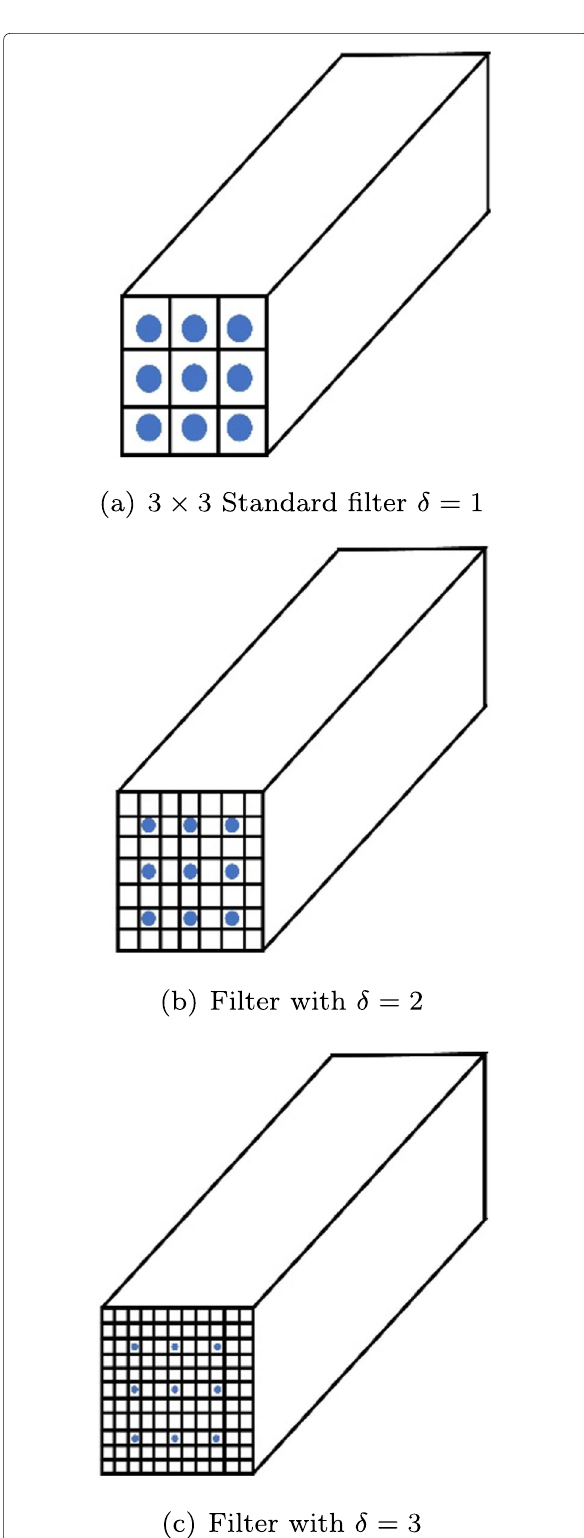
+ 1 compared to the conventional convolution to 1 N L 2 k process, which lowers computational